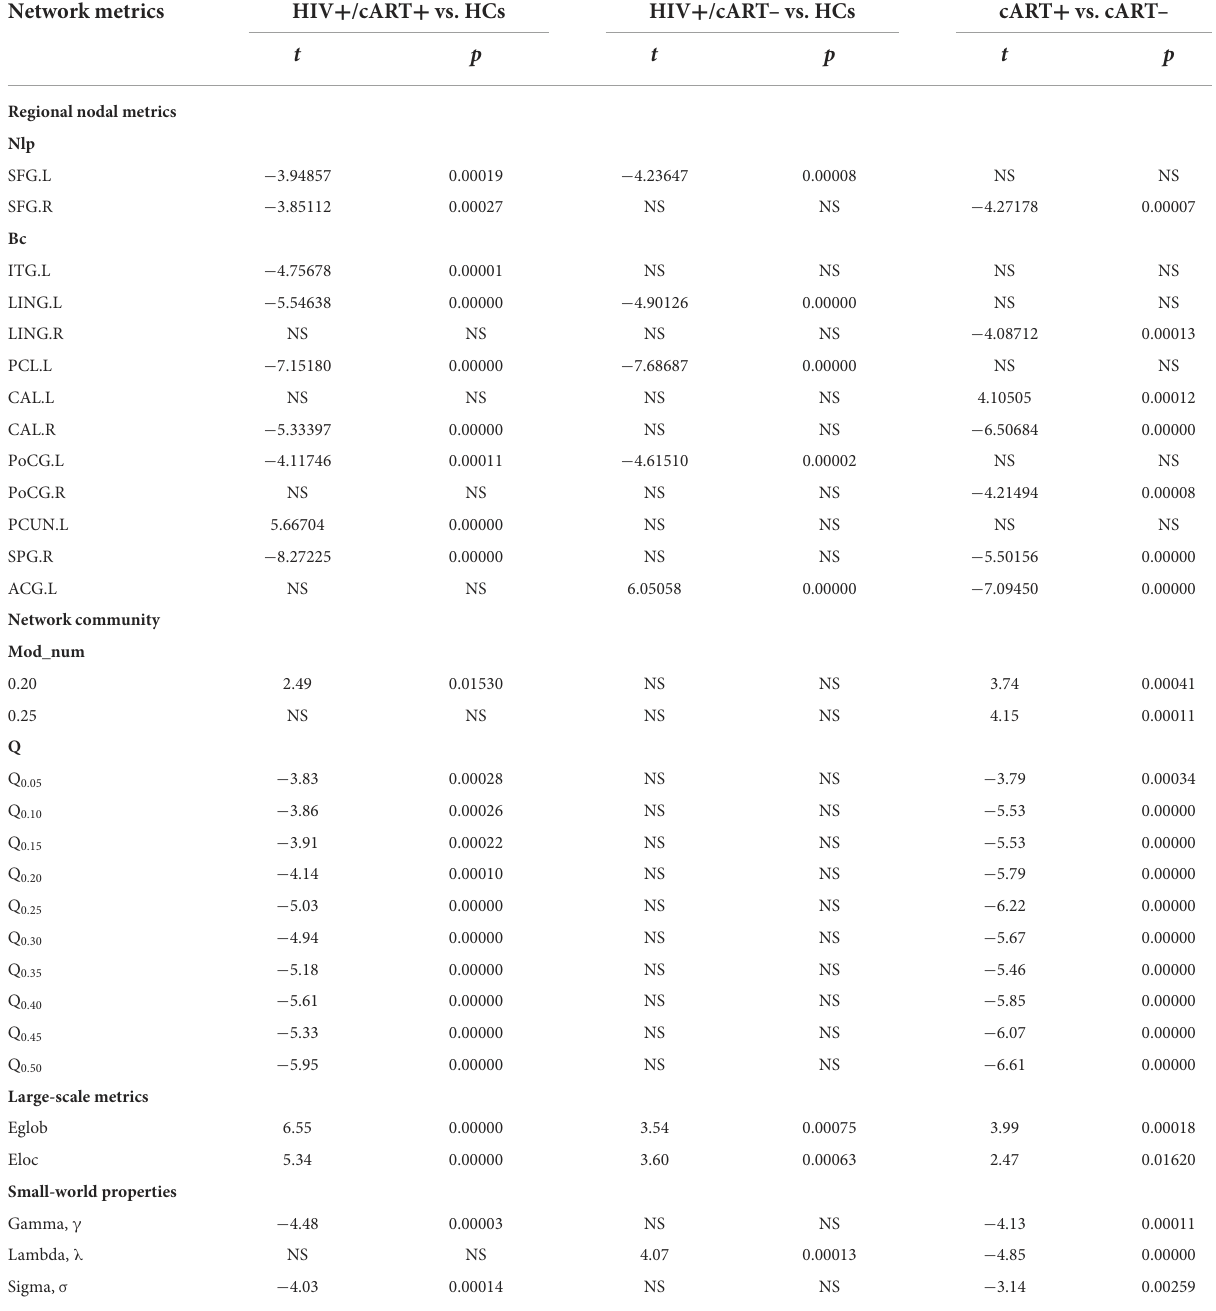
TABLE 4 Post-hoc analyses results of the altered network metrics among the three groups. Network metrics HIV + /cART + vs. HCs HIV + /cART– vs. HCs cART + vs.